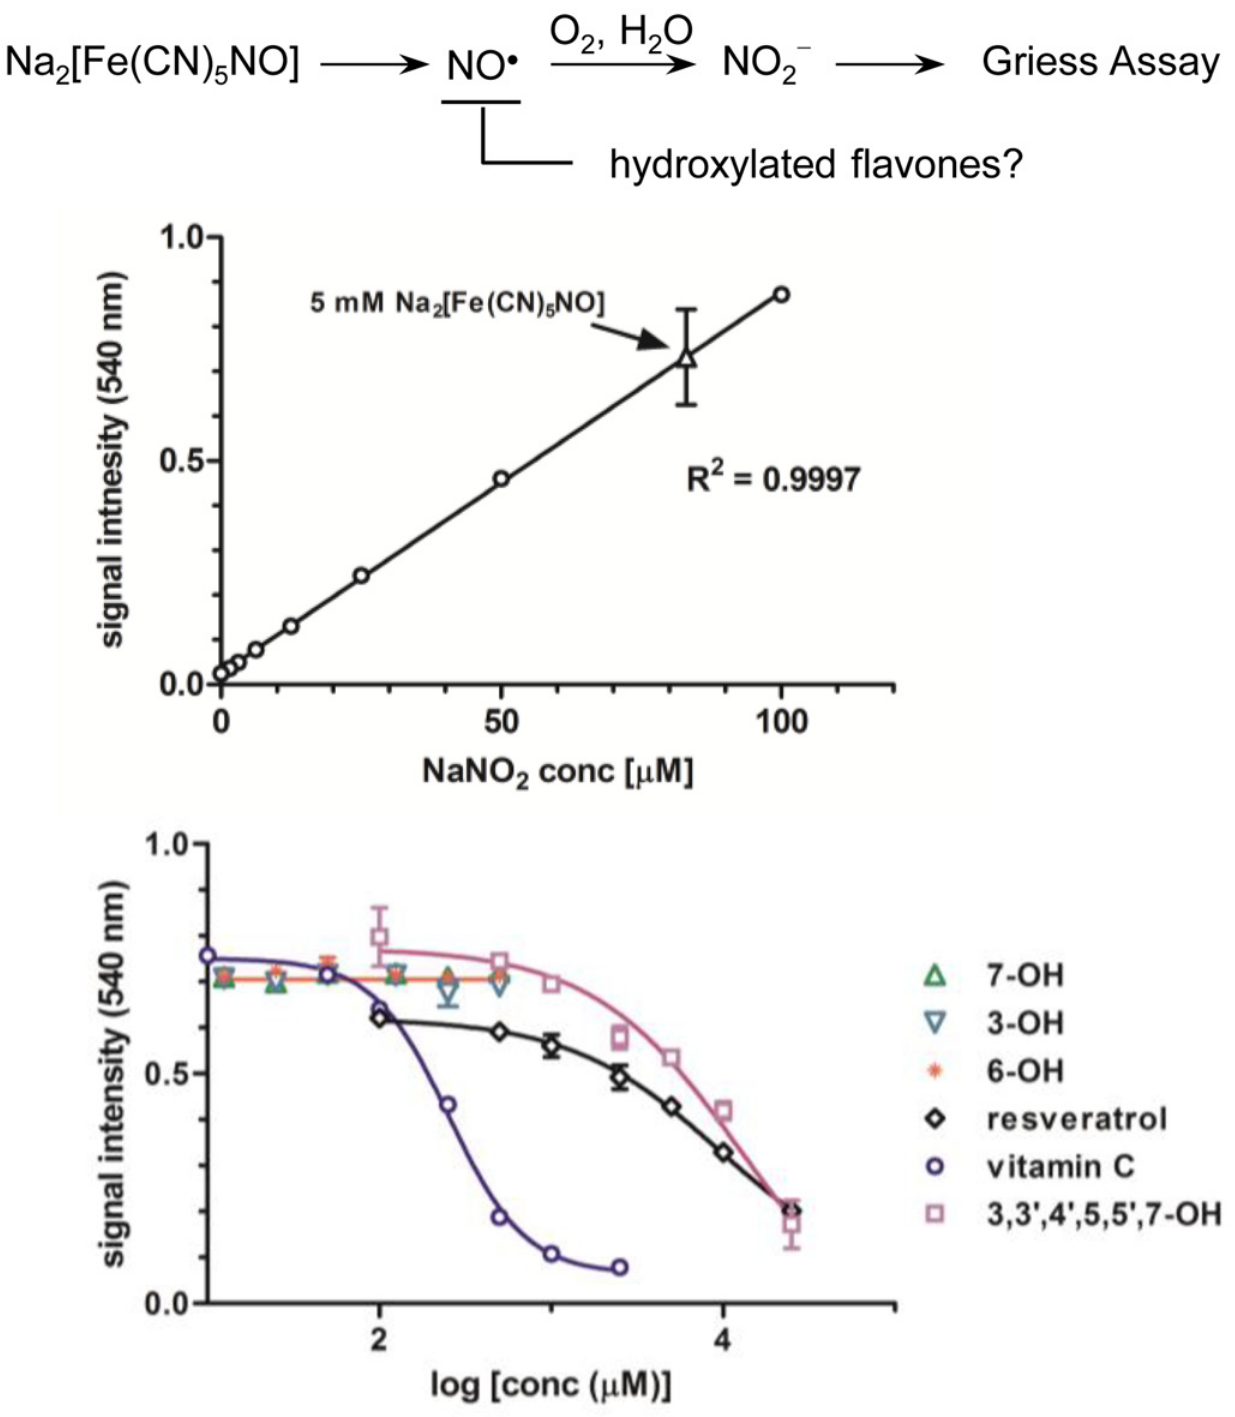
Fig 3. Direct NO radical quench study with selected monohydroxylated and polyhydroxylated flavones. Spontaneous generation of NO was achieved by a freshly prepared sodium nitroprusside stock solution (5 mM) in water in Griess assay (top). The direct quench of NO radicals were assessed on the 3-, 7- and 6-hydroxyflavone and 3,3 0 ,4 0 ,5,5 0 ,7-hexahydroxyflavone with vitamin C and resveratrol as the positive controls.